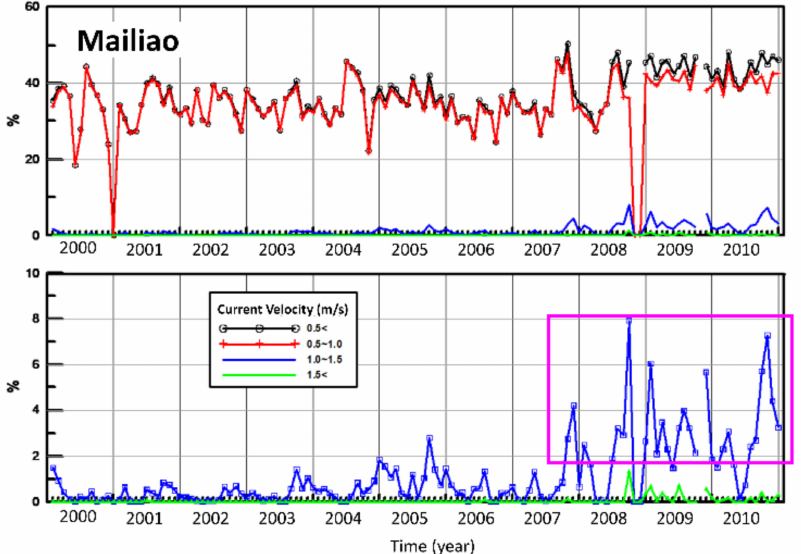
Figure 12. The current velocity